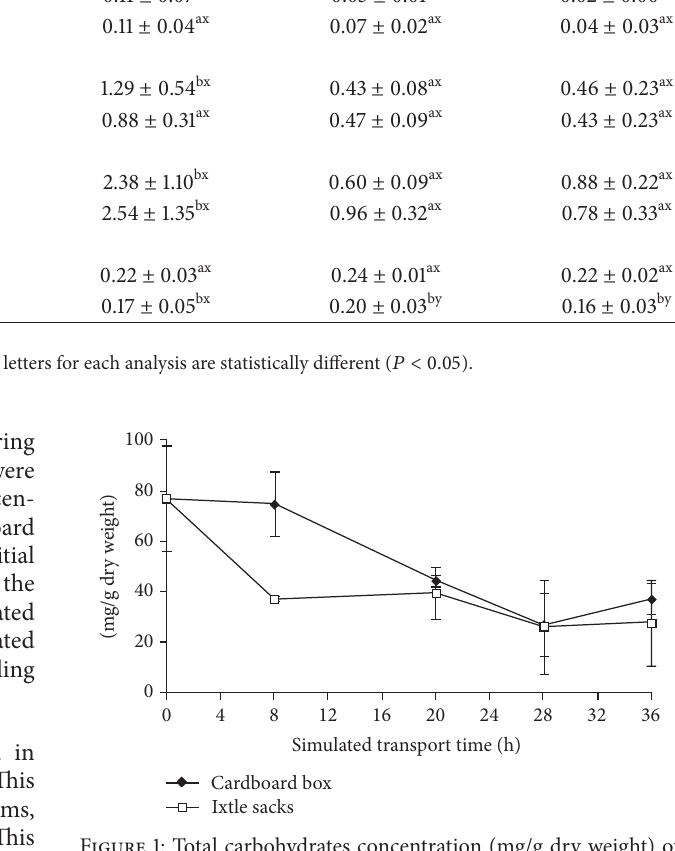
Figure 1: Total carbohydrates concentration (mg/g dry weight) of Crassostrea gigas oyster during in vivo transport in cardboard box and ixtle sacks. Data shown are mean of 𝑛 = 4 . Bars represent deviation